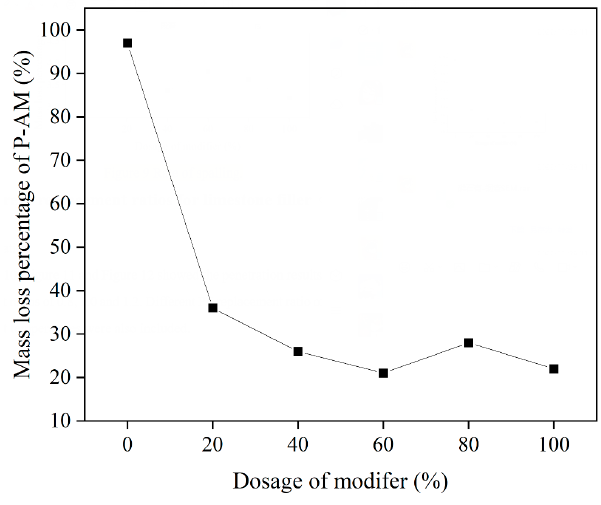
Figure 6. Mass loss percentage of P-AM.